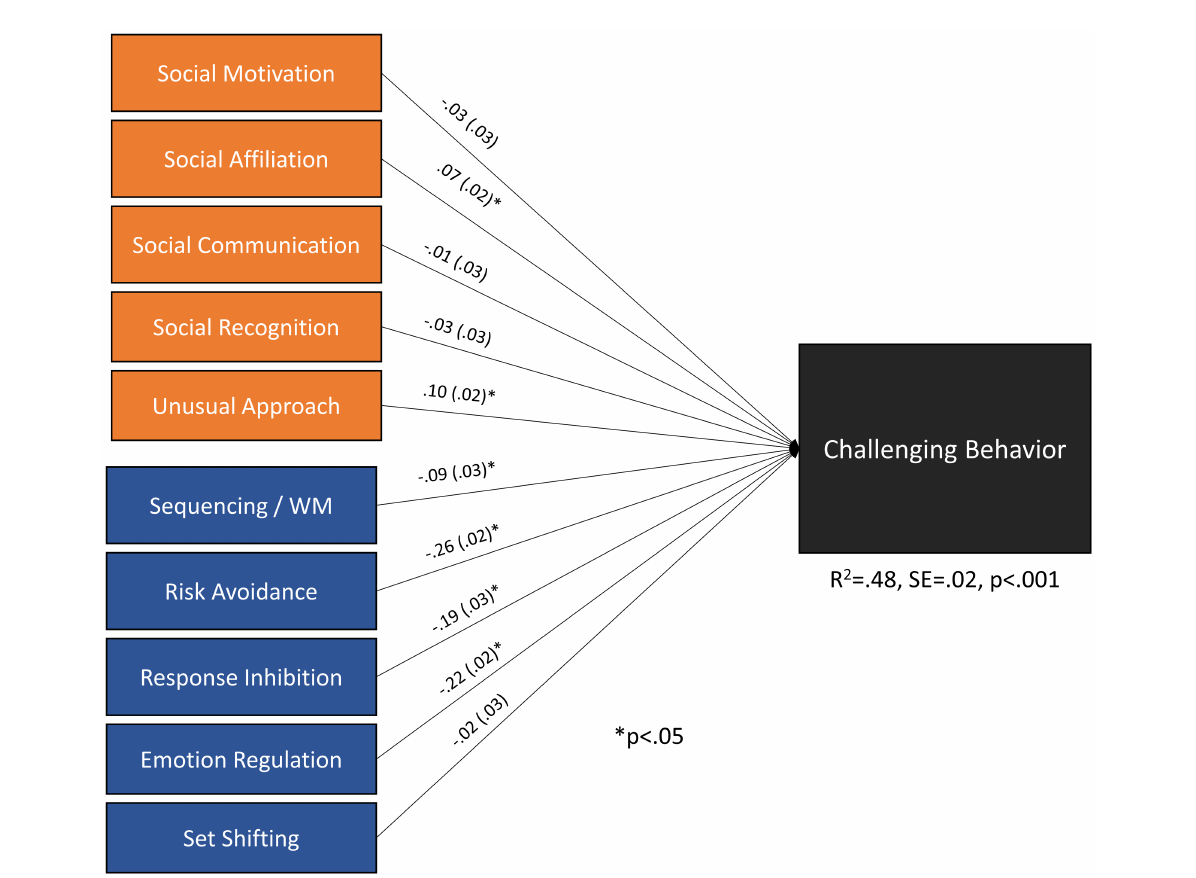
FIGURE 1 Executive and social functioning measures as predictors of challenging behavior. The model is just identified. Correlations among executive functioning subscales ranged from 0.40 to 0.76. Correlations among social functioning (SSDS) subscales ranged from |0.29| to |0.74|. The correlations between executive and social functioning subscales ranged from |0.07| to |0.63|. The pattern of residual correlations was consistent with the observed bivariate correlations among these subscales (see Supplementary material